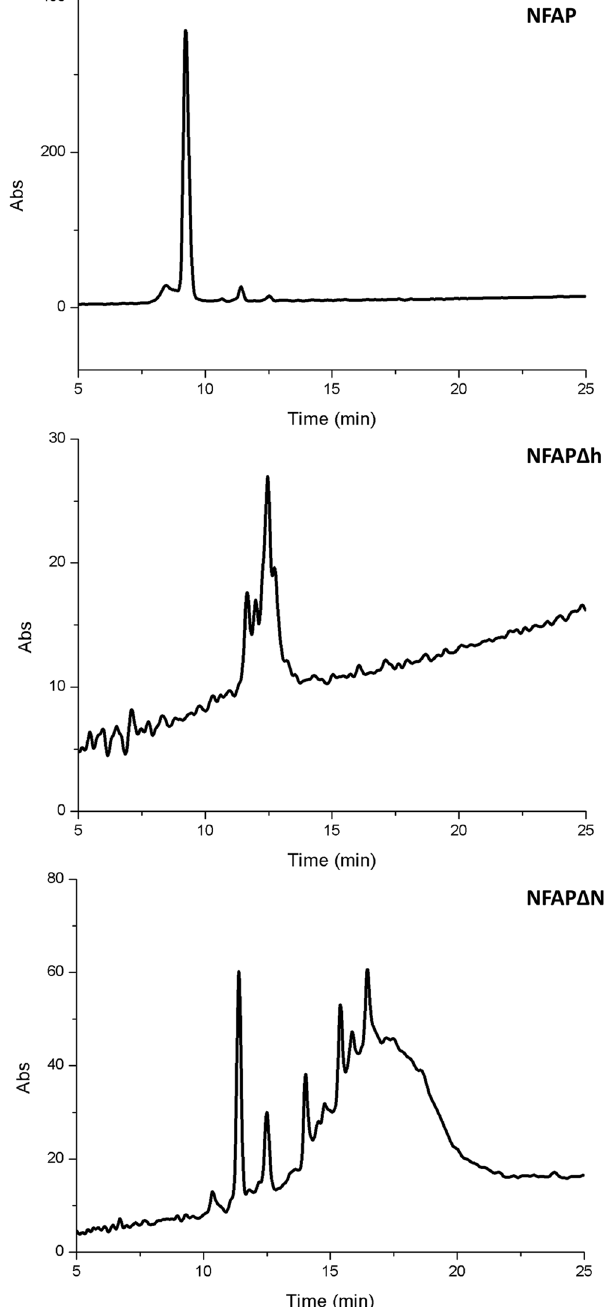
Figure 2. RP-HPLC chromatogram of recombinant NFAP, NFAP Δ h, and NFAP Δ N. Compared to NFAP, the NFAP Δ h and NFAP Δ N samples showed degradation and structural alterations, which were more prominent in NFAP Δ N than in NFAP Δ h. NFAP: recombinant Neosartorya fischeri NRRL 181 antifungal protein; NFAP ∆ h: hydrophobic core deletion NFAP mutant; NFAP ∆ N: N-terminal amino acids exchanged NFAP